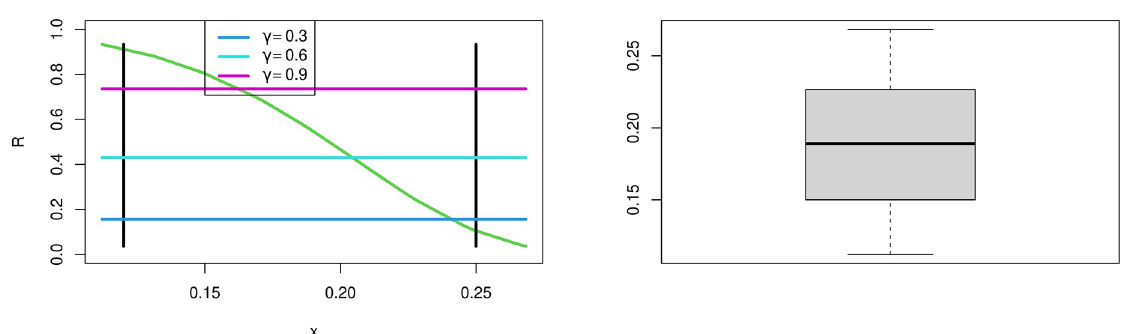
Fig 5. Fuzzy Reliability when t 1 = 0.12 and t 2 = 0.25 with different values of γ cut plot and boxplot for the MKTL distribution for the data under